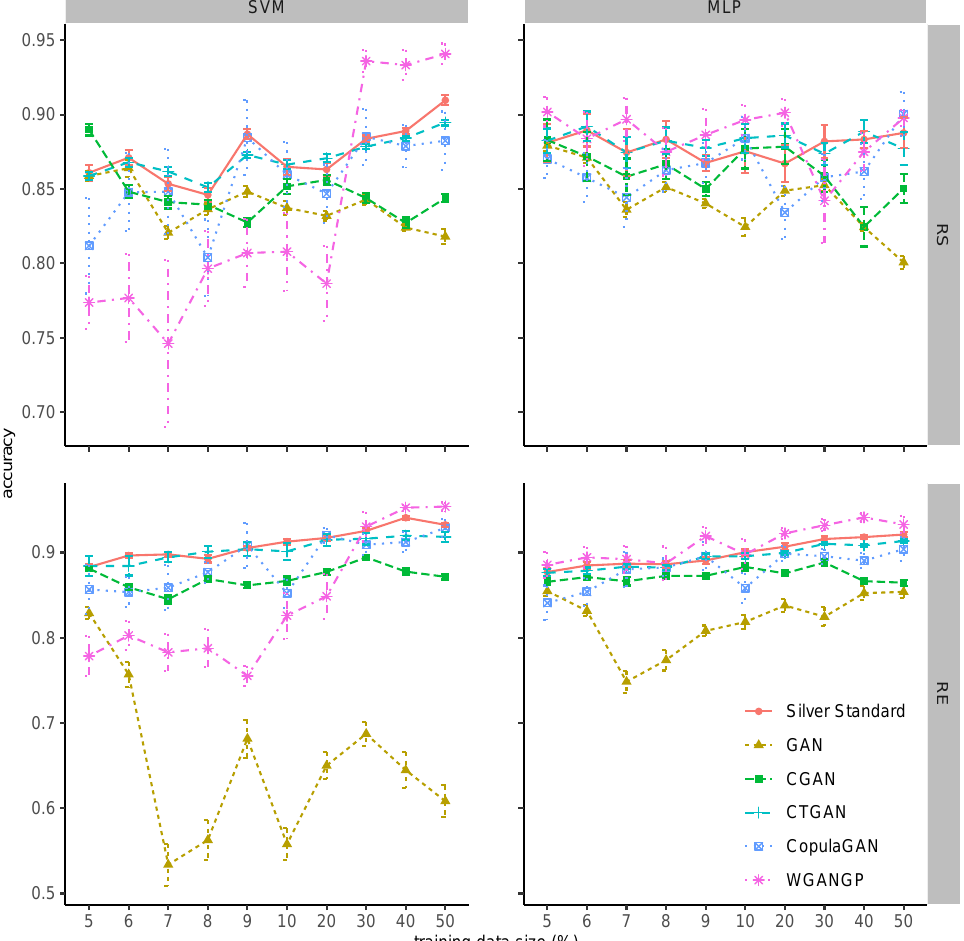
Figure 3. The mean accuracy of classifiers trained on data generated by GAN variants versus the size of the training data (as a percentage of the Train data) using the BCW dataset. Rows ( top and bottom ) show the RS and RE sampling, while columns ( left and right ) indicate the SVM and MLP classifiers. The Silver Standard only considers Train data (no generated data) for training the classifier. Error bars show the standard error of the mean over 10 samples for each